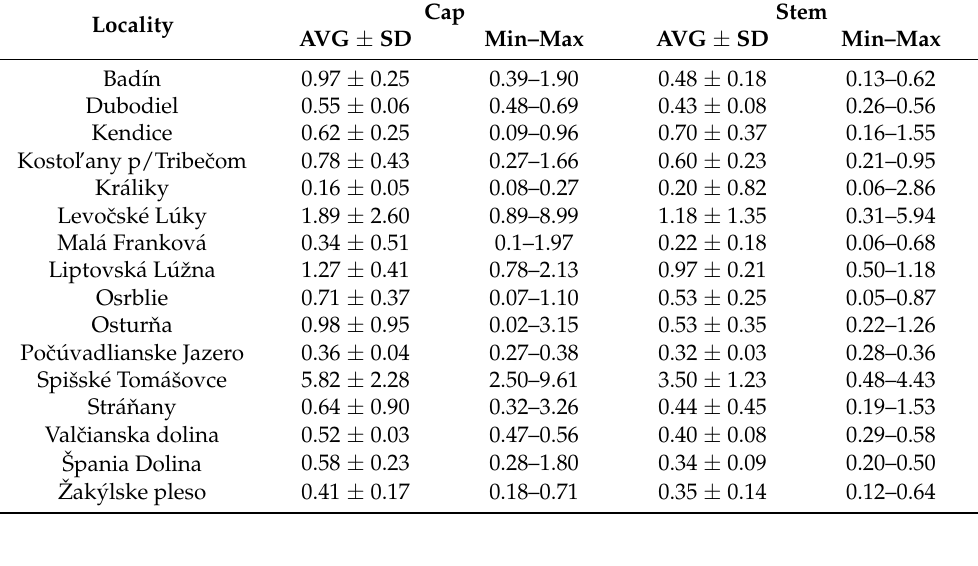
Table 3. Mercury content in fruiting bodies (mg kg − 1 DW) in the studied localities.